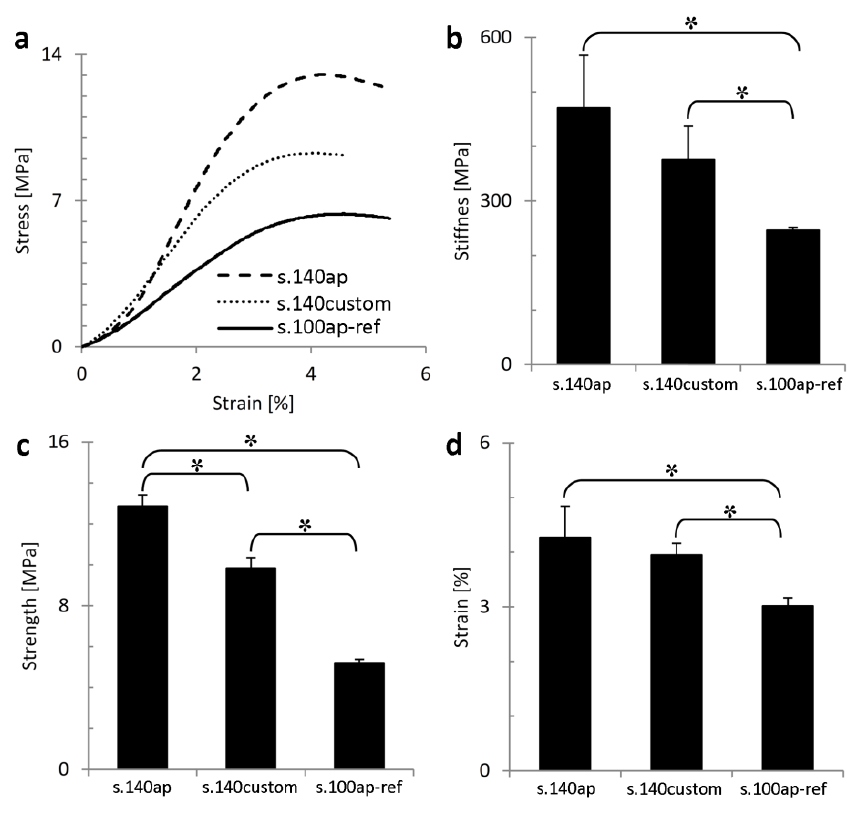
Figure 5. Mechanical analysis of the reference material (s.100ap-ref) and a structure with a designed beam thickness of 140 μm prior to (s.140ap) and after surface treatment (s.140custom): ( a ) typical stress-strain curves; ( b ) stiffness; ( c ) strength; and ( d ) ultimate